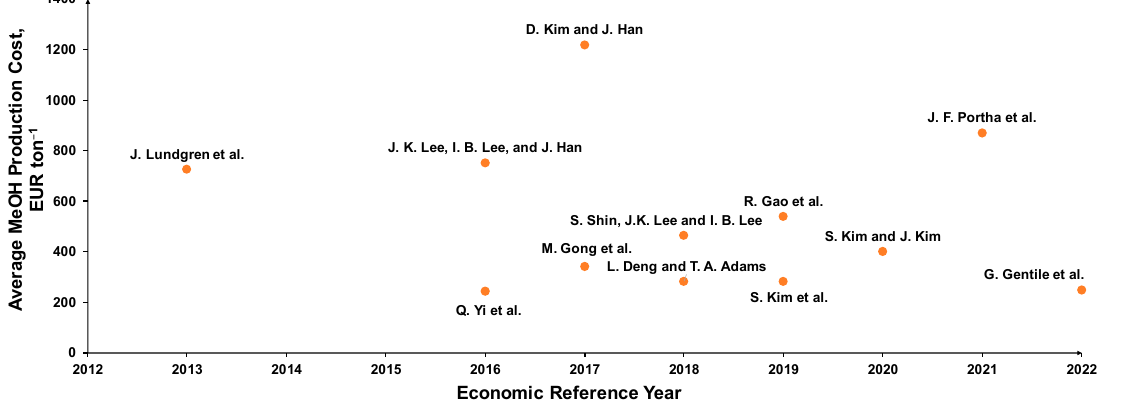
Figure 1. Literature review on average production costs of methanol synthesis from steelworks off-gases [10–21].